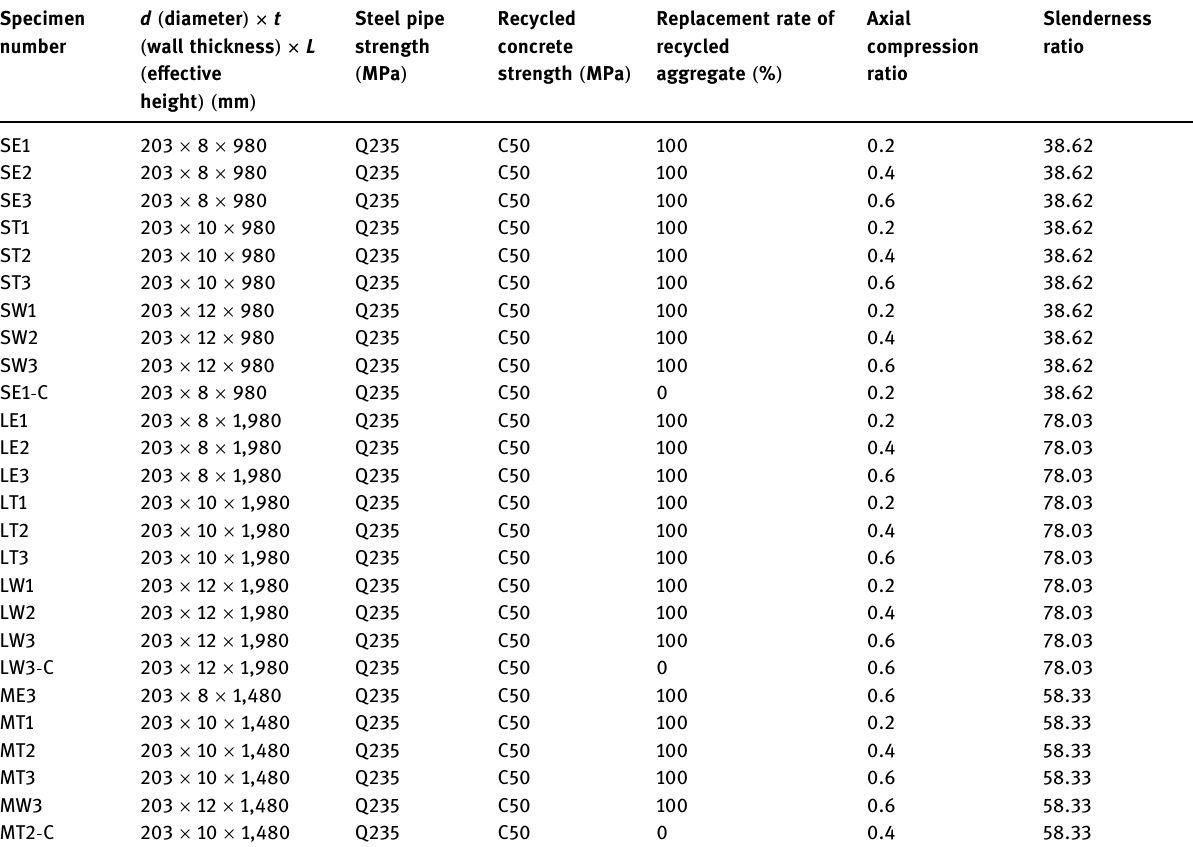
Table 1: Design parameters of test pieces Specimen